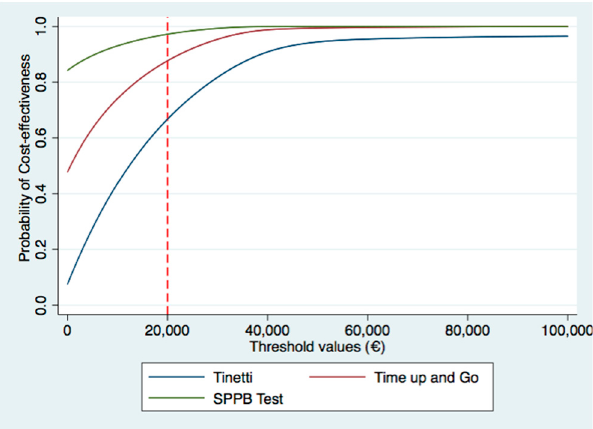
Figure 5. Cost-effectiveness analysis curves for the different outcomes.